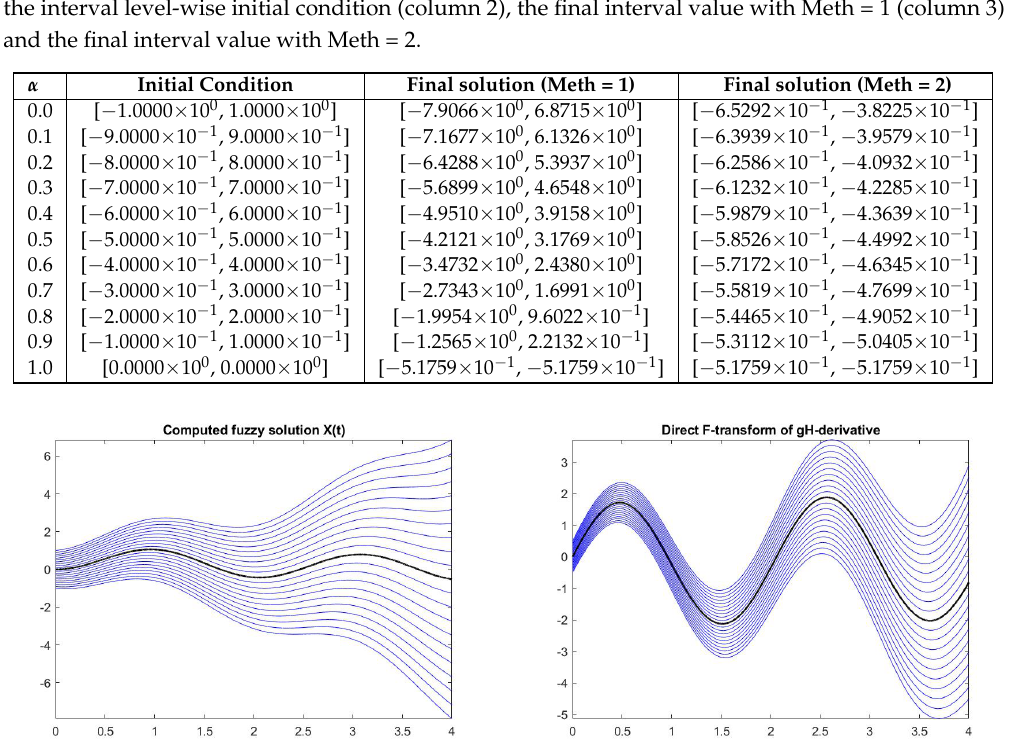
Figure 13. Problem FDE1, Meth = 1: Fuzzy-valued gH-differentiable solution ( left ) and its gH- derivative ( right ). There are no switching points.